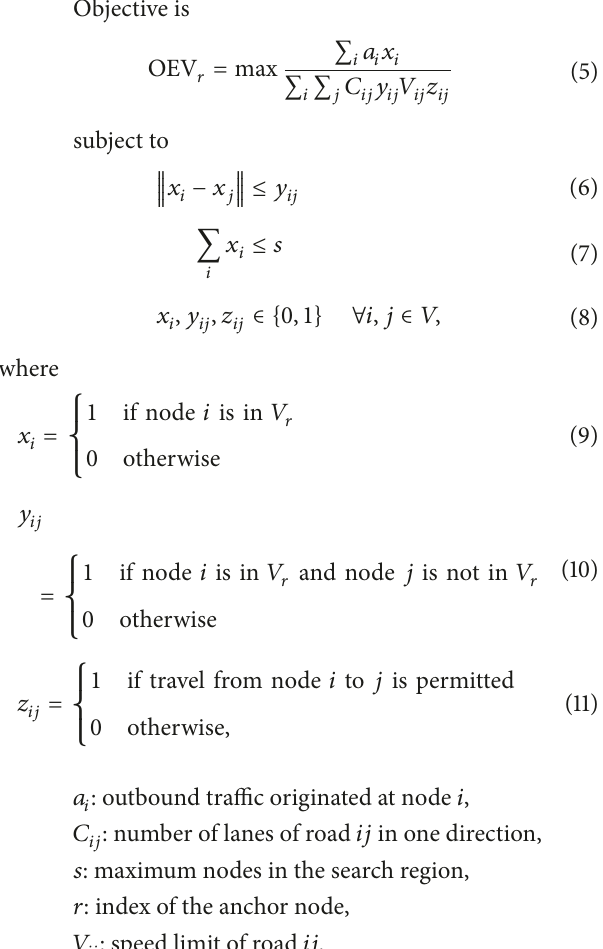
r ’s outbound evacuation vulnerability ( OEV 푟 ) is defined as